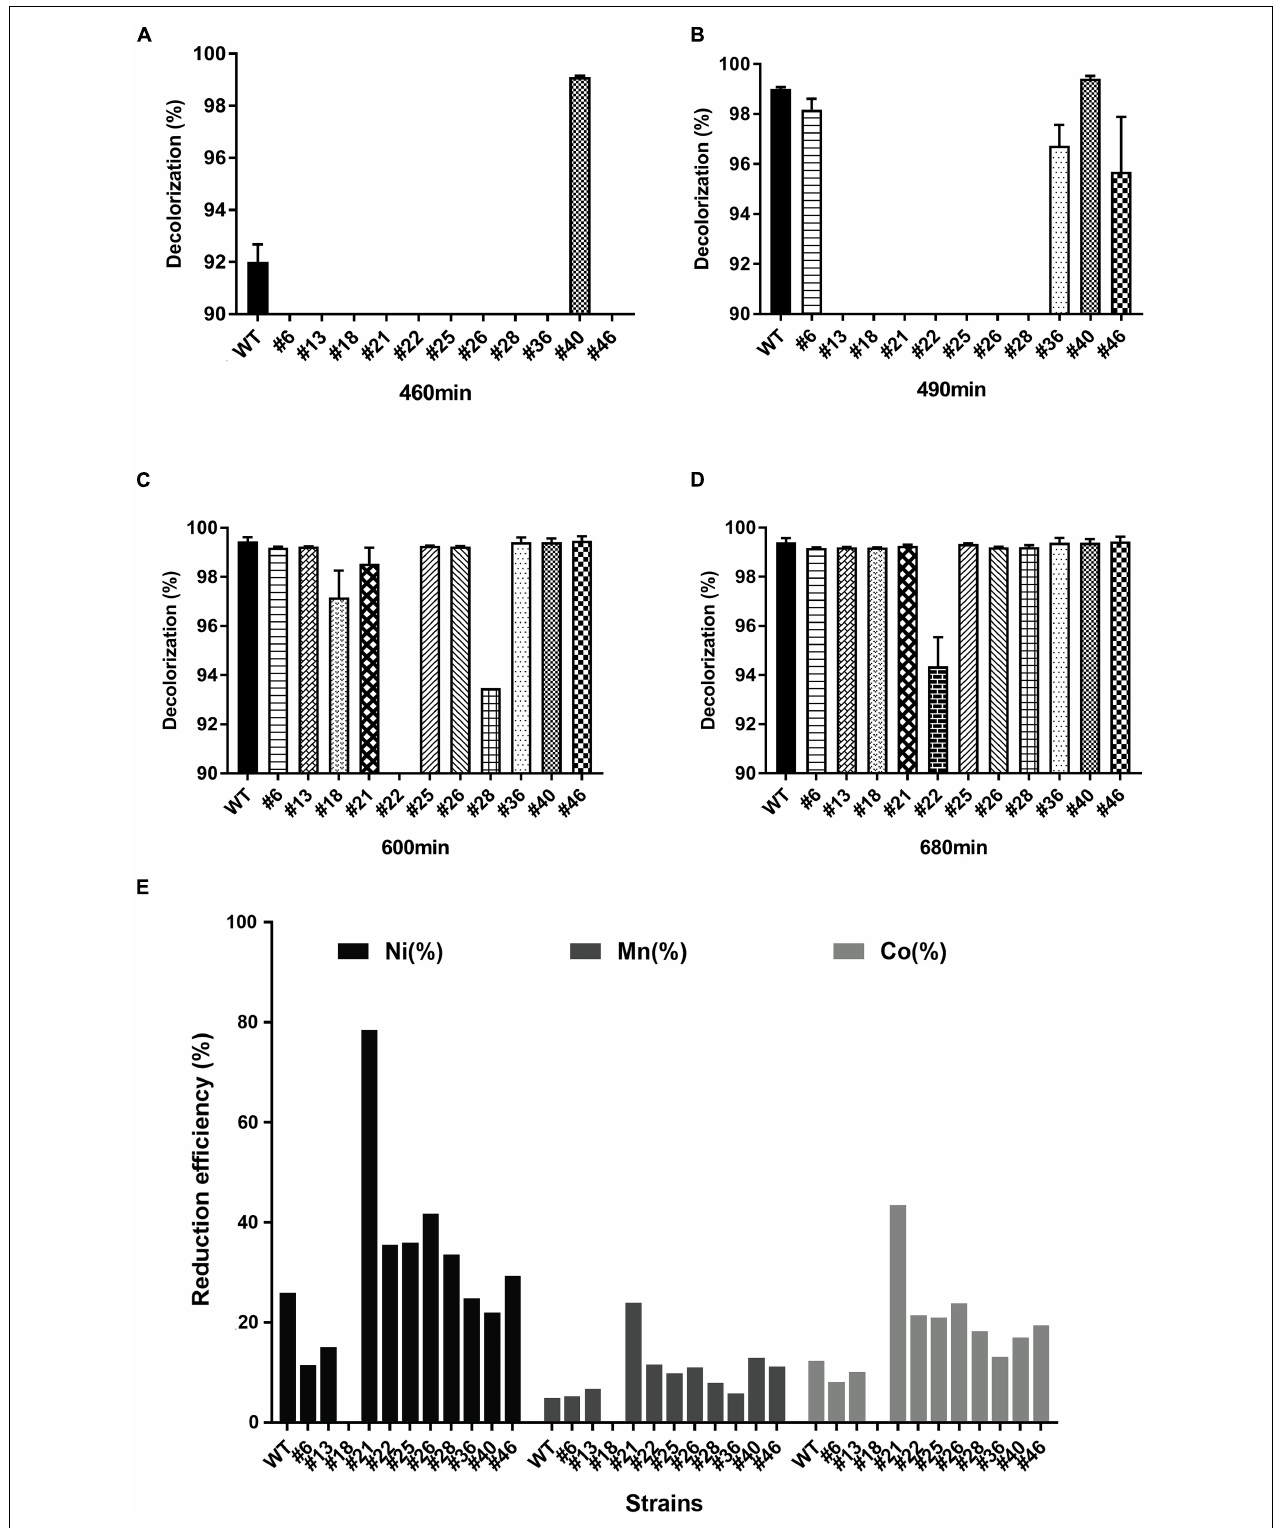
FIGURE 2 | Anaerobic degradation of AMR and bioleaching of cathodic materials by S. decolorationis Ni1-3 and RNAP mutants. The initial concentration of AMR was 8 mM. Incubation conducted anaerobically at 37 ◦ C after 460 min (A) , 490 min (B) , 600 min (C) , and 680 min (D) . The cathodic material NCM523 was from the spent LIBs, and the measurement was conducted after 48 h of incubation (E) .